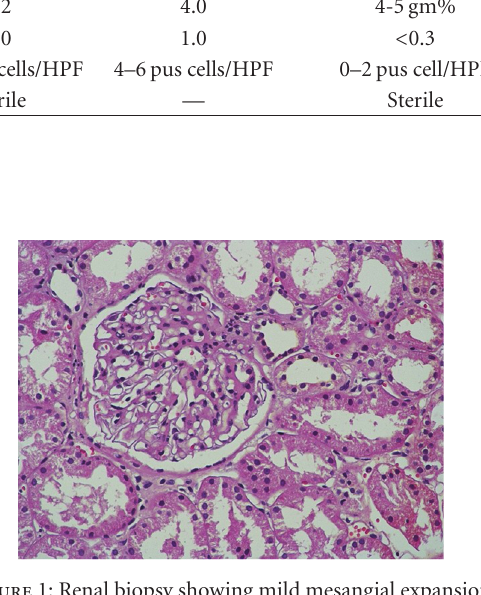
Figure 1: Renal biopsy showing mild mesangial